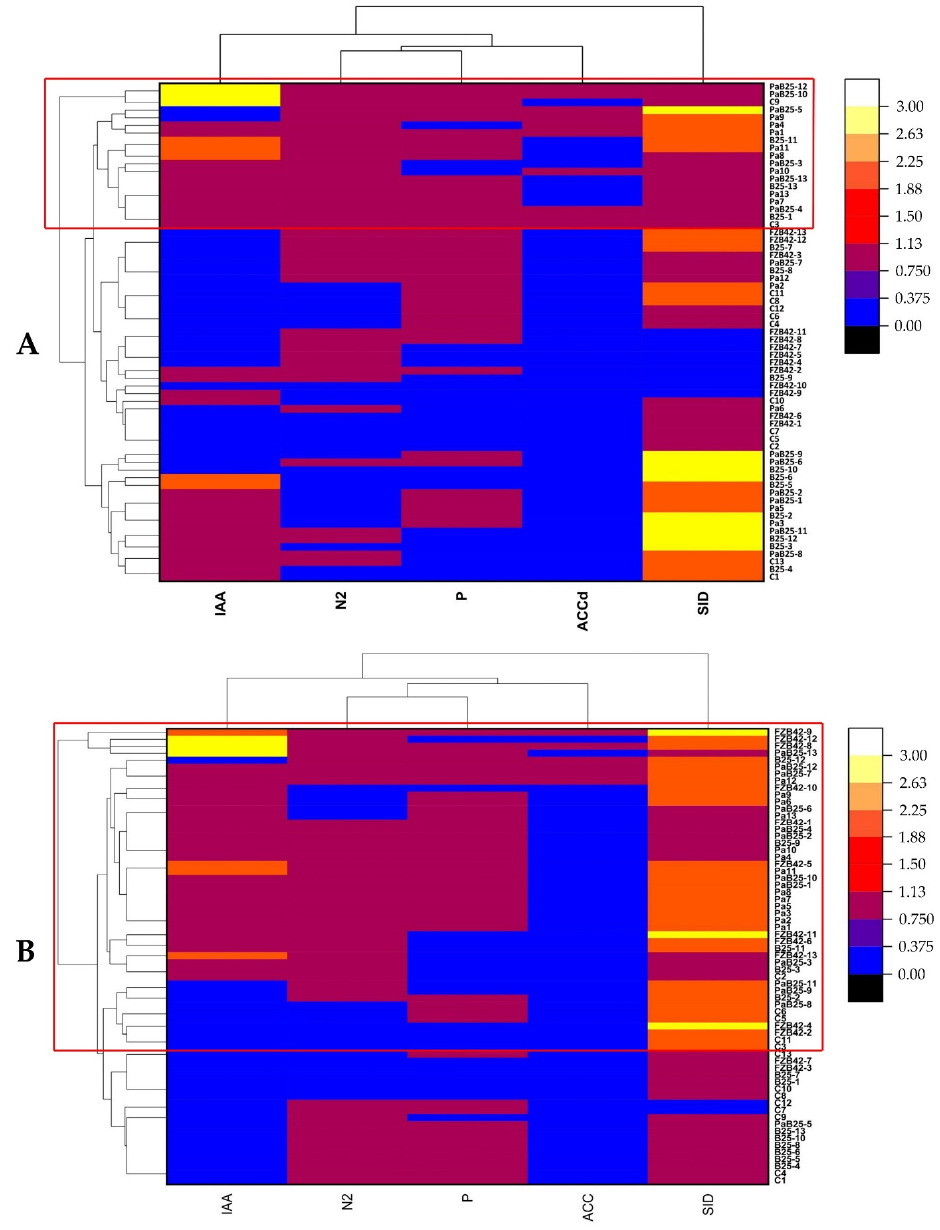
Figure 14. Clusters and heat map of bacteria isolated from rhizosphere of durum wheat inoculated with Pa, B25, FZB42, and Pa + B25 and the expression of their PGP activities (IAA: indole acetic acid production, SID: siderophore production, N2: nitrogen fixation, P: phosphate solubilization, and ACCd: 1-aminocyclopropane-1-carboxylic acid deaminase production). ( A ) Bousselam variety; ( B ) Boutaleb variety.